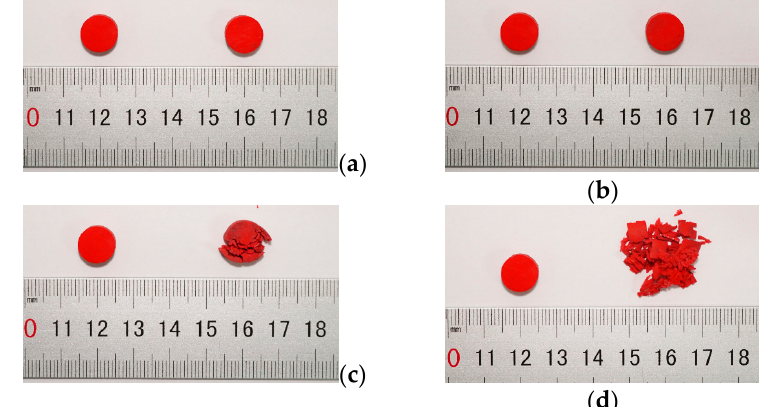
Figure 9. The failure forms of polyurea at different strain rates: ( a ) strain rate 900 s − 1 ; ( b ) strain rate 1600 s − 1 ; ( c ) strain rate 2100 s − 1 ; ( d ) strain rate 3000 s − 1 .